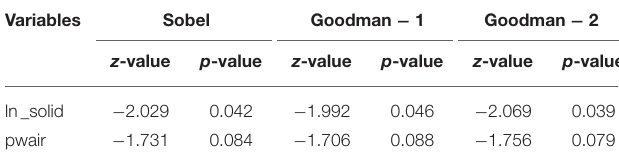
TABLE 6 | Sobel-Goodman mediation